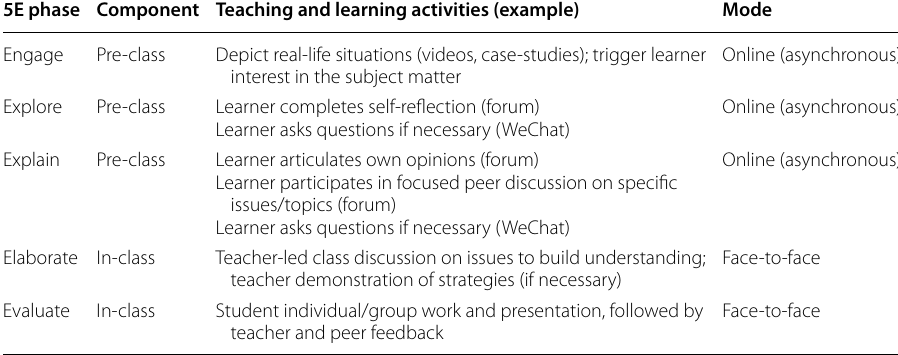
Table 3 Phases of the 5E framework and examples of activities in a conventional flipped